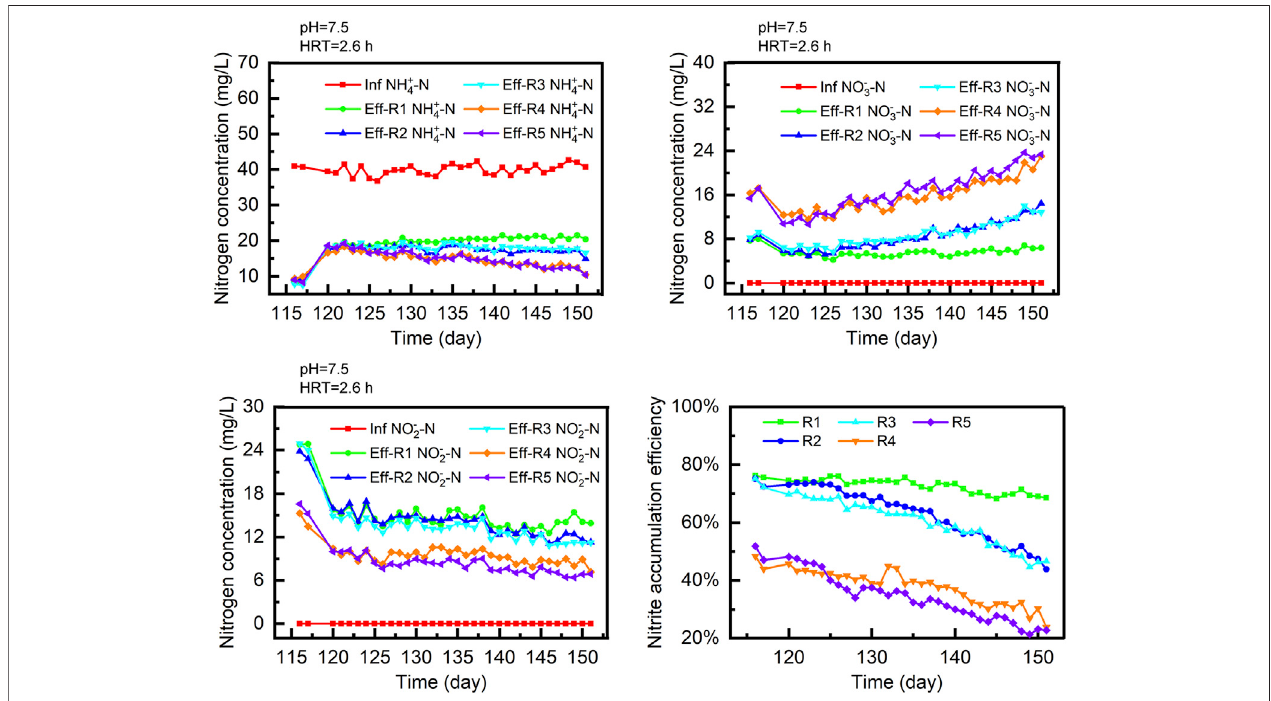
FIGURE 3 | The performance of each reactor in phase